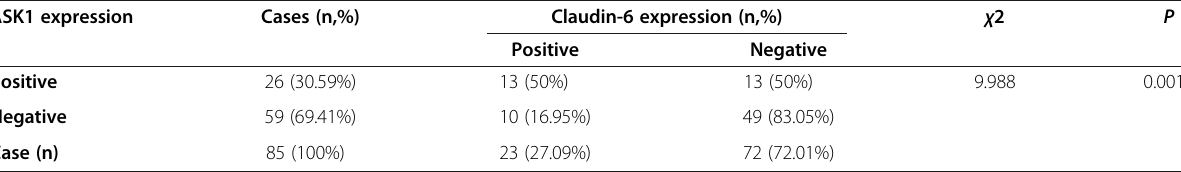
Statistical analyzed by Pearson ’ s chi-square